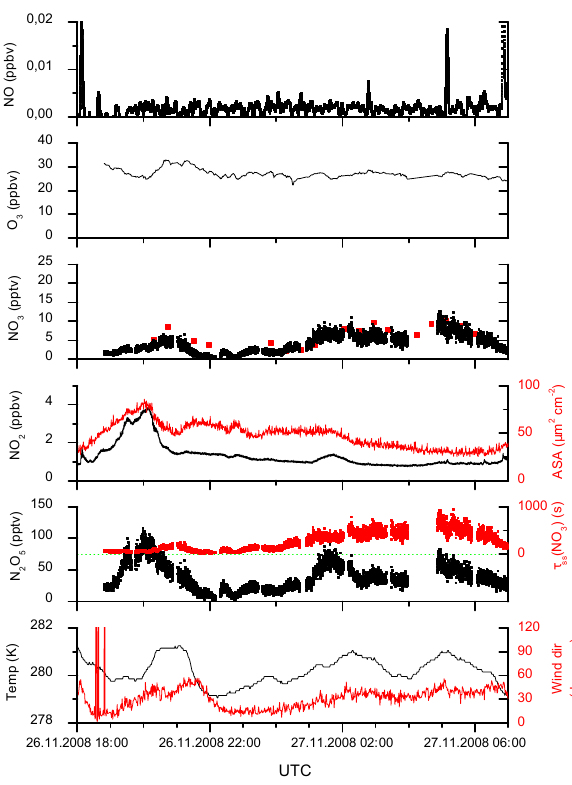
Fig. 10. Overview of measurements on the night of 26–27 Novem- ber (air from the continental sector). For NO 3 , the black dataponts are CRD measurements, the red squares ( ∼ 30min resolution) are DOAS measurements.